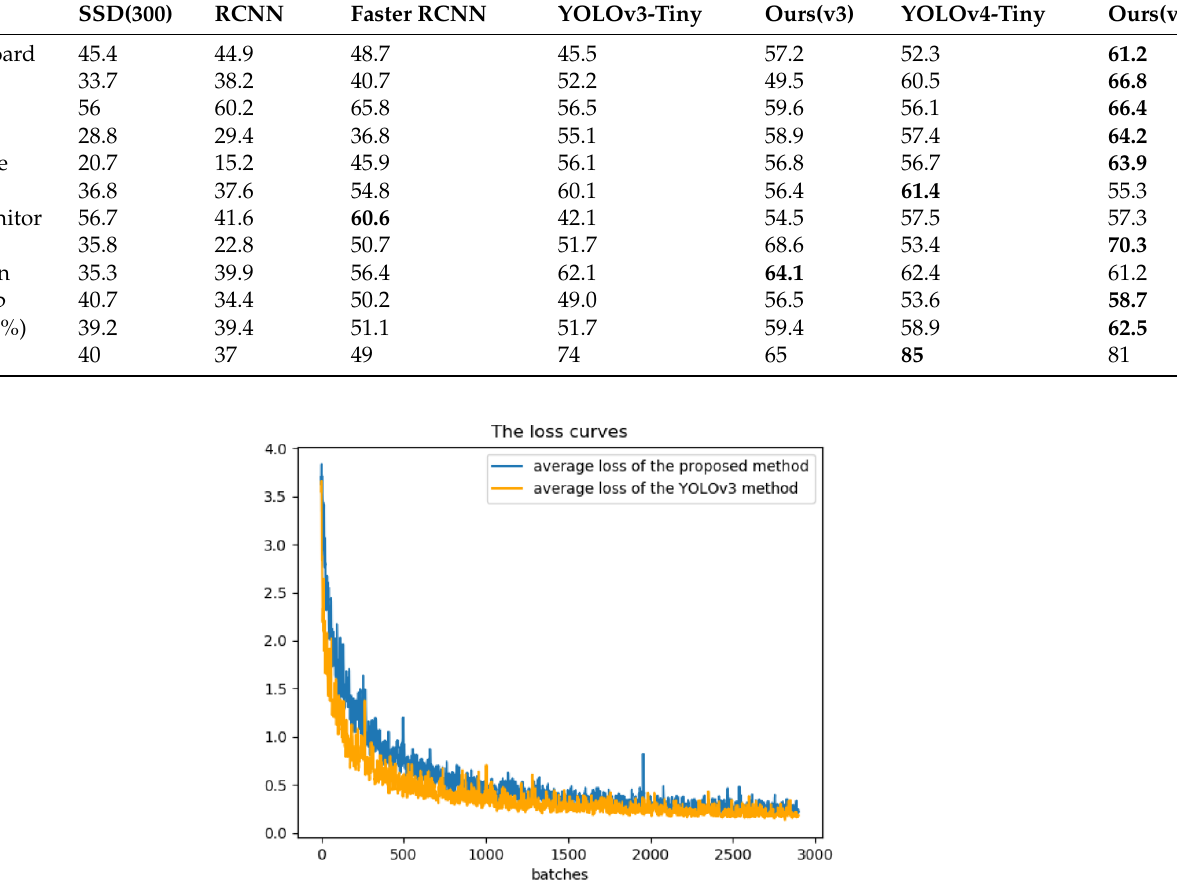
Figure 9. The training loss curves of our proposed method and